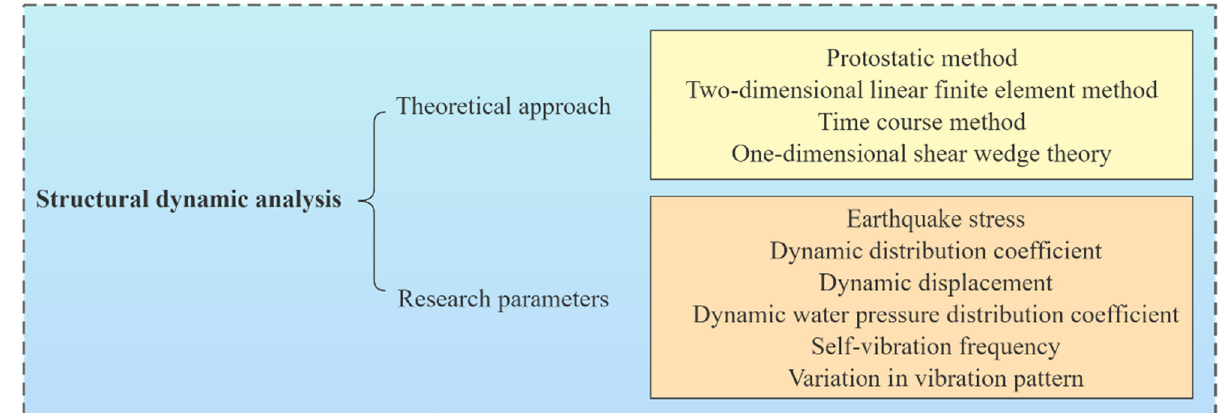
Figure 3: Classi fi cation of dynamic analysis methods for CSG